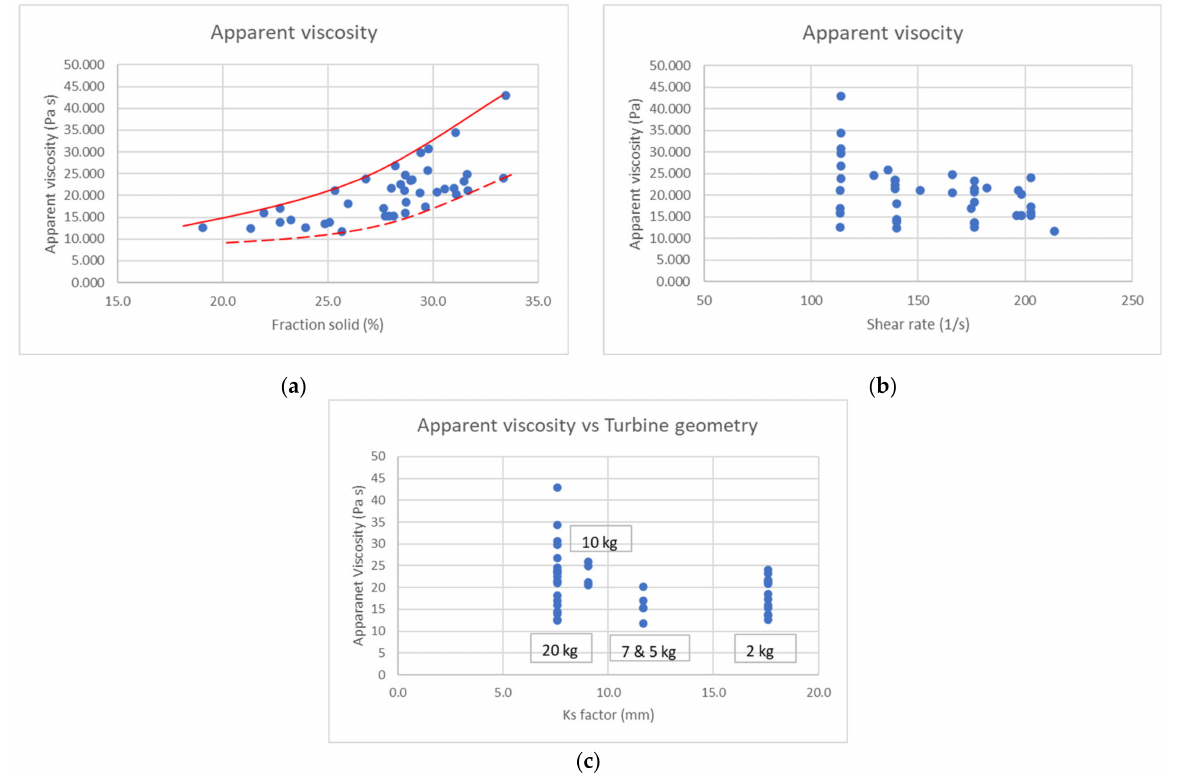
Figure 5. The apparent viscosity as a function of ( a ) fraction solid where the solid line shows the upper bound for the 20 kg shot weight and the lower bound generated by shot weighs 7 kg and below, ( b ) shear rate dependence and ( c ) the influence of